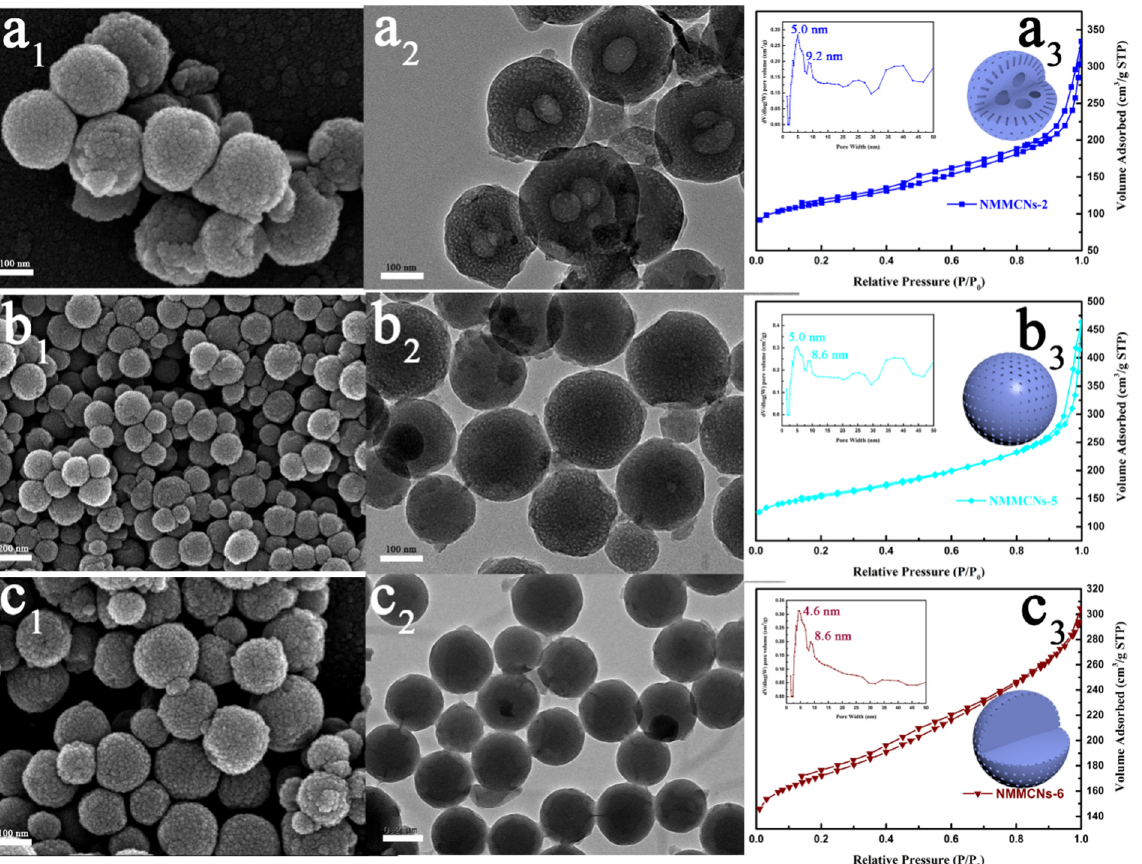
Figure 5. SEM images ( a 1 – c 1 ), TEM images ( a 2 – c 2 ), nitrogen adsorption–desorption isotherms ( a 3 – c 3 ) and corresponding PSD curves (( a 3 – c 3 ), inset) of NMMCNs synthesized with different E/W ratios. (Row ( a ), NMMCNs-2; Row ( b ), NMMCNs-5; Row ( c ), NMMCNs-6).